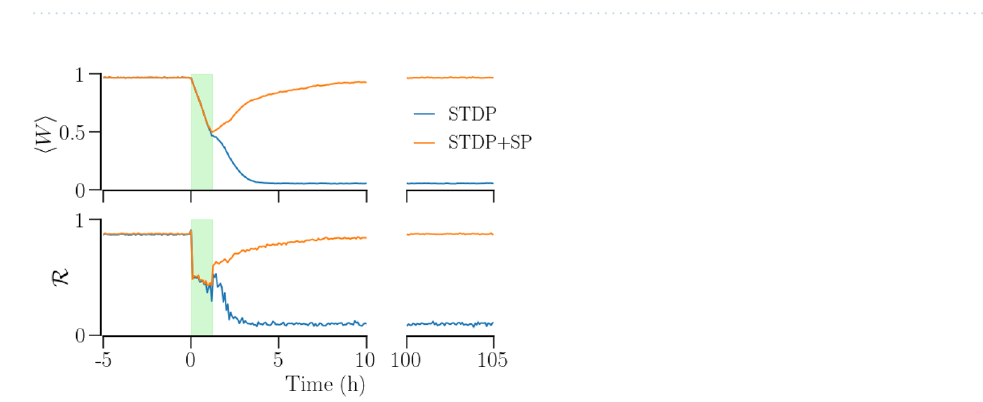
Figure 10. Dependence of oscillator In- and Out- NDD ( β i and β out j , respectively) on the characteristic frequency of the oscillator in a network of non-identical oscillators with STDP + SP, observed in the asymptotic states. ( a ) shows the dependence in a synchronized state and ( b ) shows the same in a desynchronized state. In contrast, for a network with STDP only, the In- and Out-NDD remain independent of the oscillator frequency as the network structure cannot change with activity and remains the same as initially set. Parameters are a = 0.3 , γ = 15 ; for synchronized state— β( 0 ) = 0.4 , � W � = 1 ; for desynchronized state— β( 0 ) = 0.2 , � W � = 0.2 .